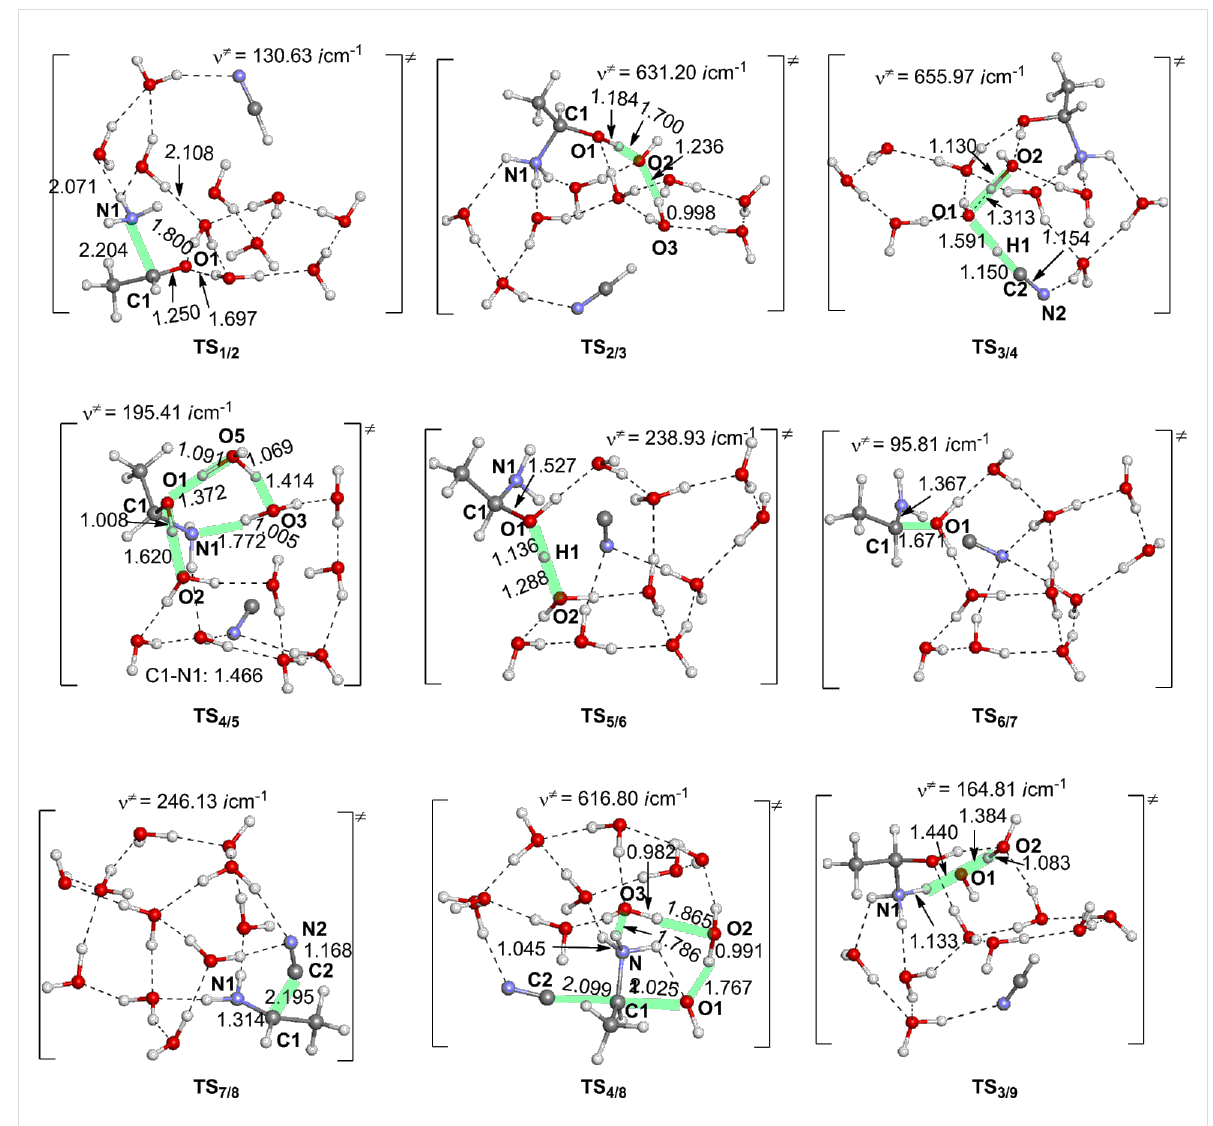
Figure 1: Geometries of transition states along the reaction from acetaldehyde ( 1 ) to the aminonitrile 8 . Distances are in Å. TS 1/2 means, for instance, a transition state for the step 1 → 2 .